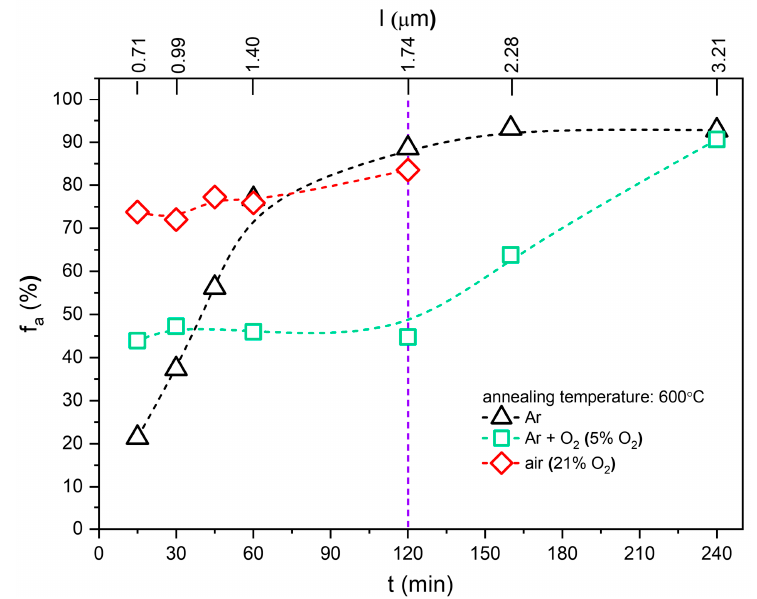
Figure 2. The impact of reaction time on the amount of anatase fraction in different annealing atmospheres at 600 °C.